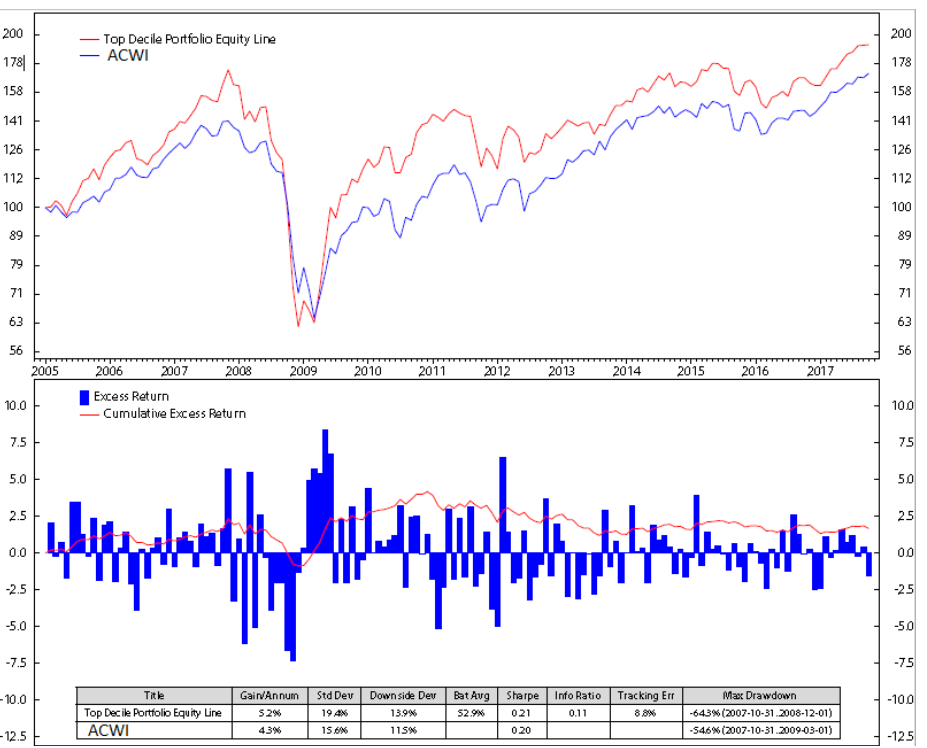
Figure A9. Global stock selection from January 2005 to September 2017 based on stock long-term sales growth factor.